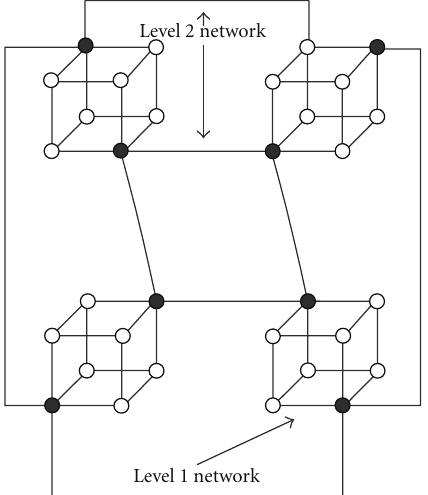
Figure 1: The replication technique.